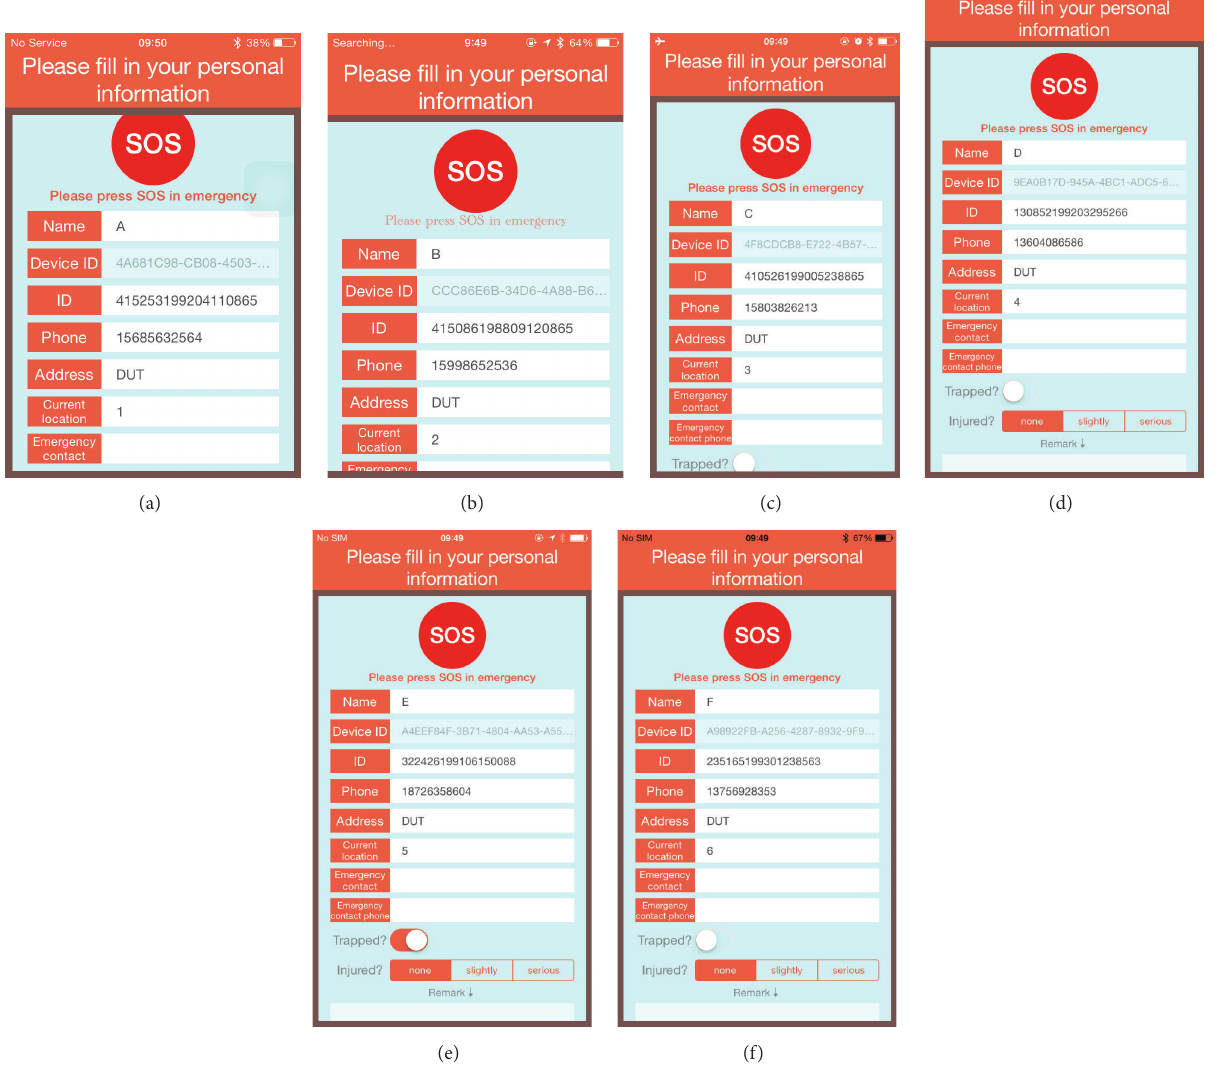
Figure 5: Inputting interfaces and networks.